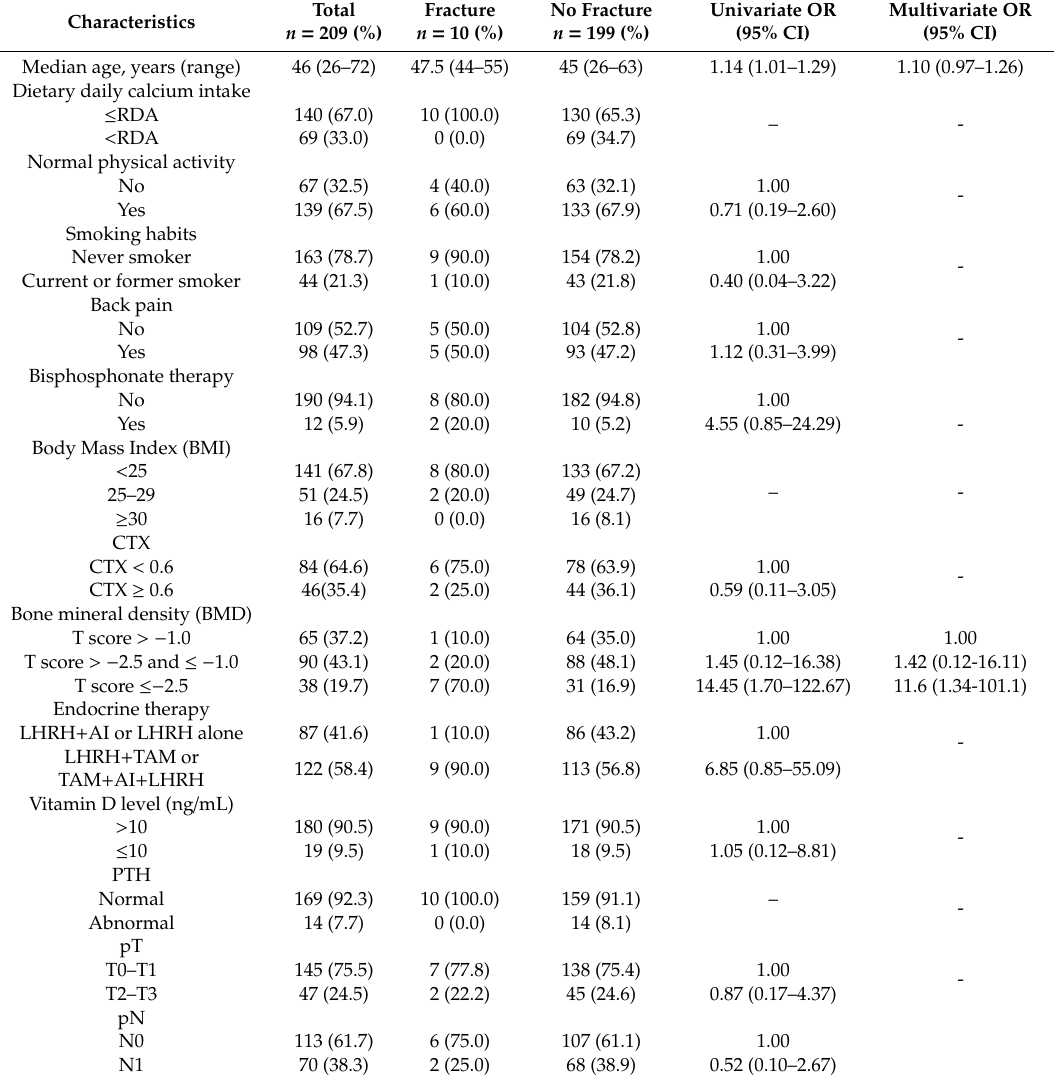
Table 2. Univariate and multivariate risk of morphometric vertebral deformities in pre-menopausal